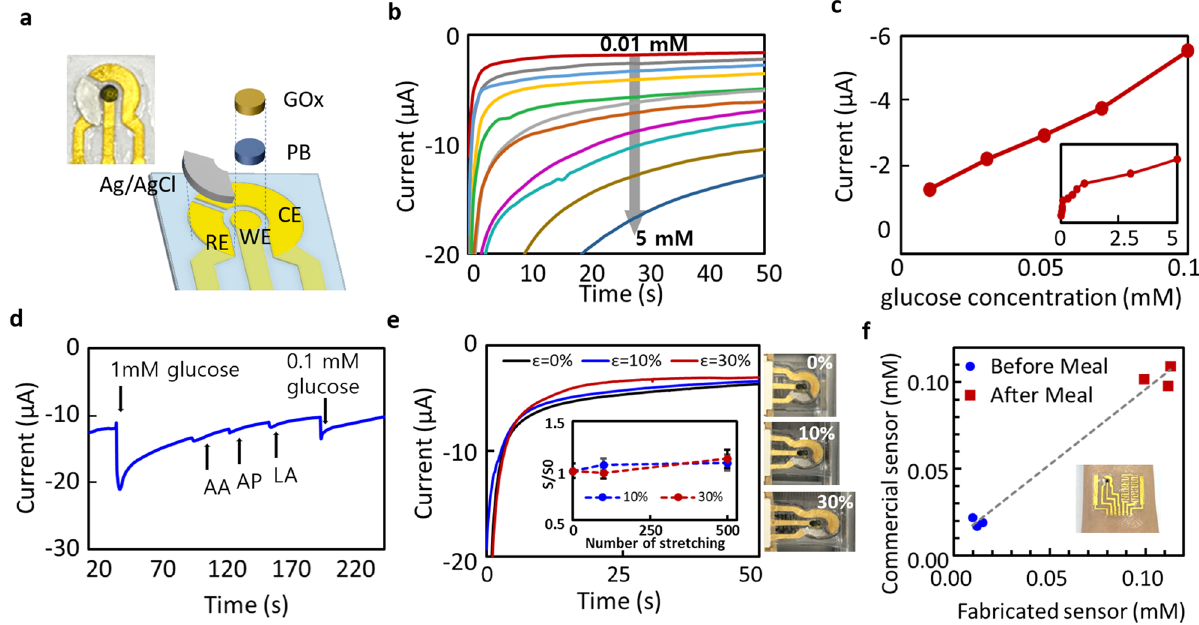
Figure 5. Characterisation as an electrochemical sensor for glucose monitoring. ( a ) Schematic of the electrode functionalisation of three electrodes using GOx and PB on the WE and Ag/AgCl on the RE. ( b ) CA curves of the glucose sensor in response to varying glucose concentration from 0.01 to 5 mM. ( c ) Calibrated curve of the response current versus the glucose concentration showing a linear relationship within the range of human sweat (inset shows the current response to the glucose concentration up to 5 mM). ( d ) CA curve of the sensor in the presence of physiological molecules such as AA, AP, and LA, showing a good selectivity towards glucose molecules. ( e ) CA responses to 0.1 mM glucose concentration from the patch sensors in rest states and stretched by 10 and 30%. Inset shows the relative sensor responses (S/S 0 ) after repetitive stretching cycles of 10% and 30%. (f) Correlation of glucose concentration from human sweat measured and calibrated by the fabricated sensor (x-axis) with those by commercial glucose sensing strips (y-axis) before and after